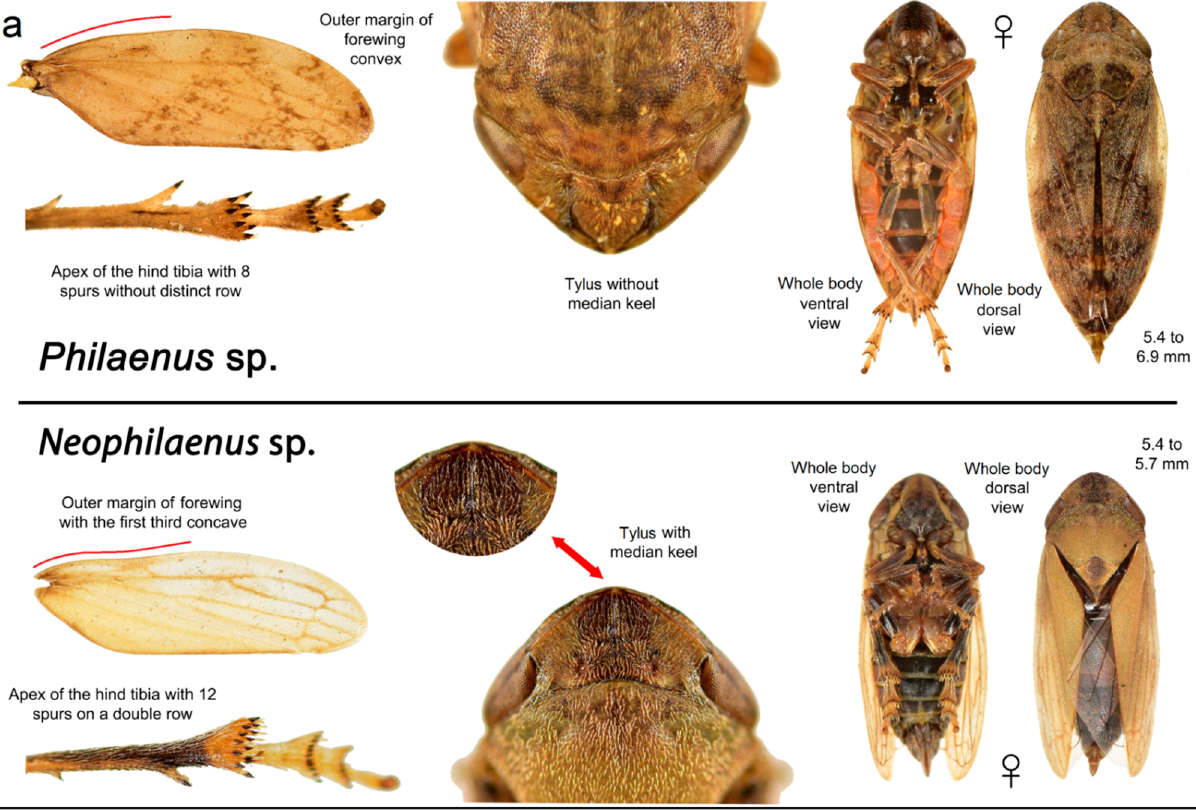
Figure 2. Morphological identification of the spittlebugs at the genus ( a ) and species ( b ) levels. 2.3. Detection of X. fastidiosa in Vector Insects DNA extraction was carried out using the CTAB (hexadecyltrimethylammonium bromide) protocol. Briefly, two tungsten carbide beads were inserted into each tube and the heads were mechanically disrupted with a Qiagen TissueLyser II (Qiagen Inc, Hilden, Germany). An amount of 500 μ L of CTAB buffer (20 g of CTAB/L, 1.4 M NaCl, 0.1 M Tris/HCl, and 20 mM EDTA) was added and the solution was mixed and incubated at 65 °C for 30 min. A total of 500 μ L of chloroform:isoamyl alcohol 24:1 was added and the